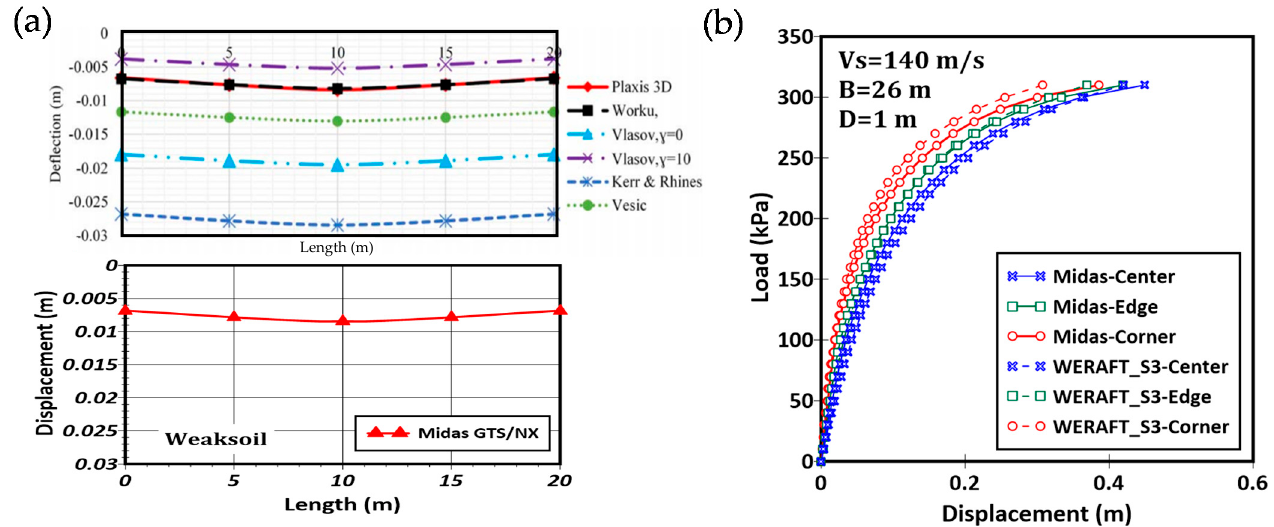
Figure 3. Validations of the Midas analysis: ( a ) comparison with Plaxis analysis on linearly elastic soils; ( b ) comparison with FD analysis on strain hardening clay.